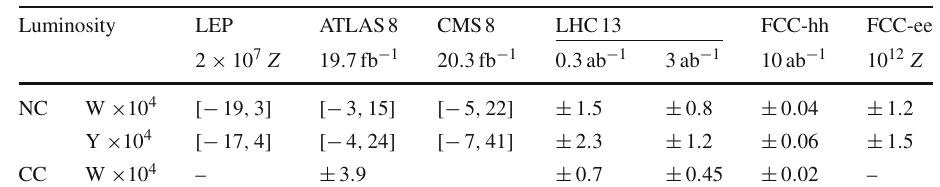
Table 8.1 Reach at 95% CL on W and Y from different experiments. The bounds from neutral DY are obtained by setting the unconstrained parameter to zero. From